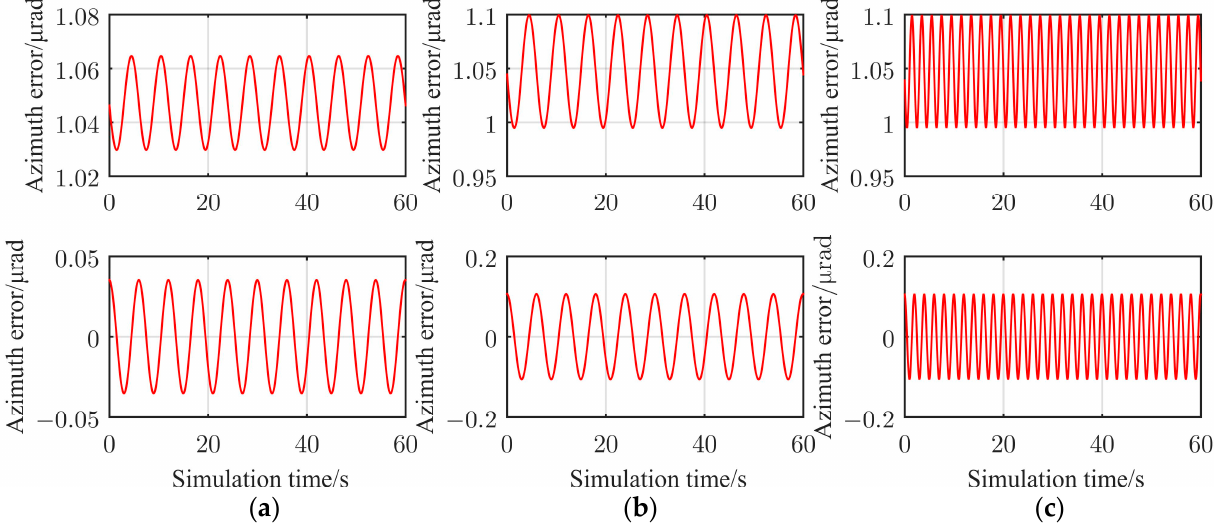
Figure 16. The error curve of the calculation of the indirect numerical calculation method in the re fl ector coordinate system O 45 X 45 Y 45 Z 45 . ( a ) a = 1°, ω = 60°/s; ( b ) a = 3°, ω = 60°/s; ( c ) a = 1°, ω = 180°/s.